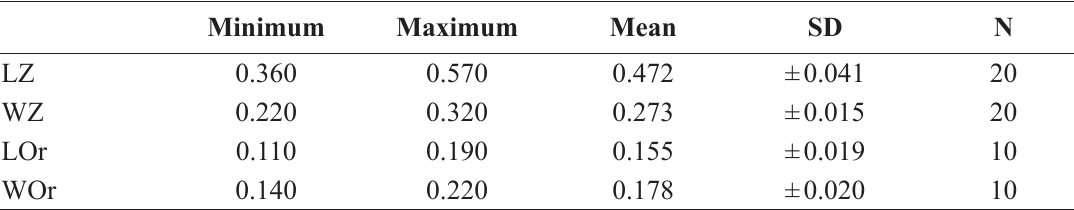
Table 10 . Measurements in mm of Labioporella hariparensis Guha & Gopikrishna, 2007, Burdigalian, lower Miocene, Chhasra Formation, western Kachchh, Gujarat, India (GIS/B 0533 to 0548). Abbreviations: see Material and methods.